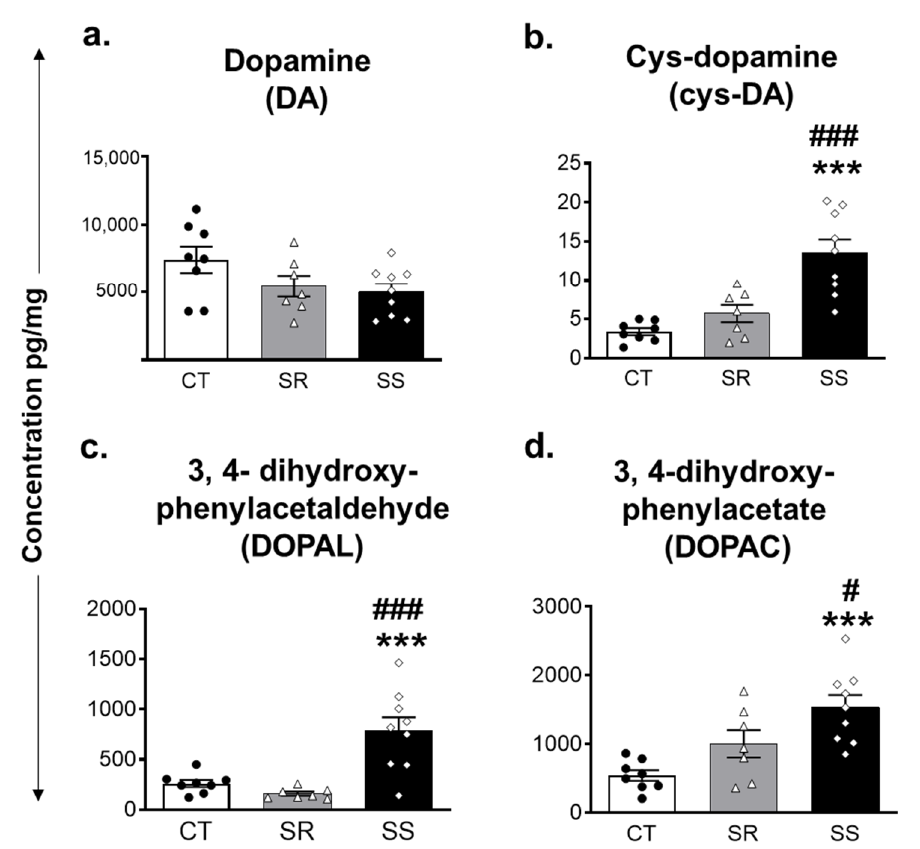
Figure 3. Levels of dopamine and its metabolites in the dorsal striatum. ( a ) DA, ( b ) cys-DA ( c ) DOPAL, and ( d ) DOPAC in SR, SS, and control rats. Key to statistics: *** p < 0.001, comparison control vs. SR and SS groups; # p < 0.05, ### p < 0.001, comparison between SR and SS groups. All values represent means ± SEM. CT (n = 8), control saline rats; SR (n = 7), shock-resistant, vulnerable, compulsive METH takers; SS (n = 9), shock-sensitive, non-vulnerable